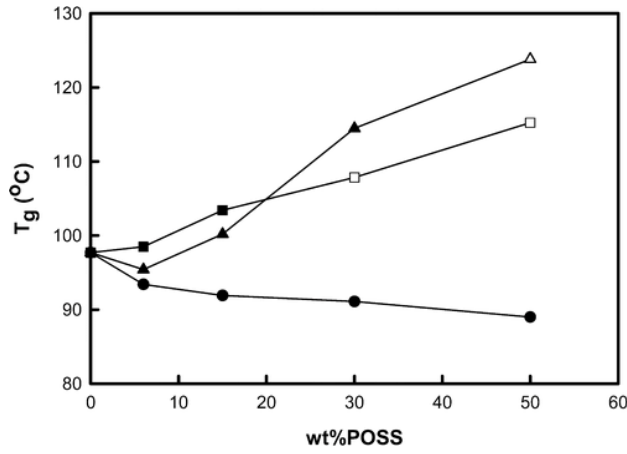
Figure 9. Glass transition temperature (Tg) is plotted vs. the amount of POSS for POSS-containing PS-based diblock copolymer nanocomposite films: ( ● ) iBuPOSS, ( ) CpPOSS and ( ▲ ) CyPOSS. Reproduced with permission from Wu et al . [93]. Copyright 2009, American Chemical